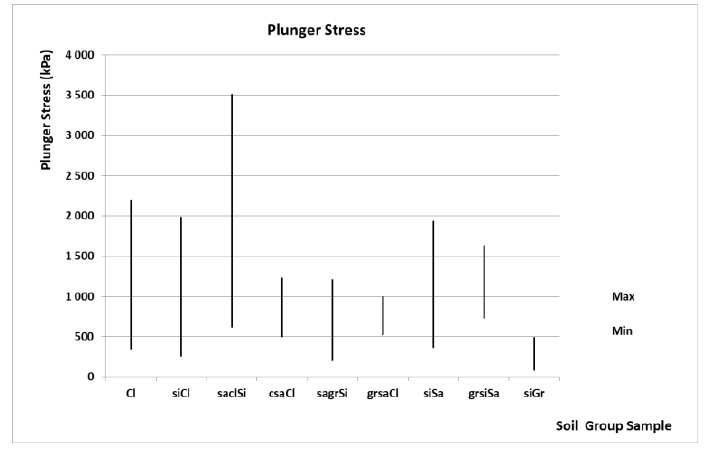
Figure 11. Intervals of plunger stress for all soil types.